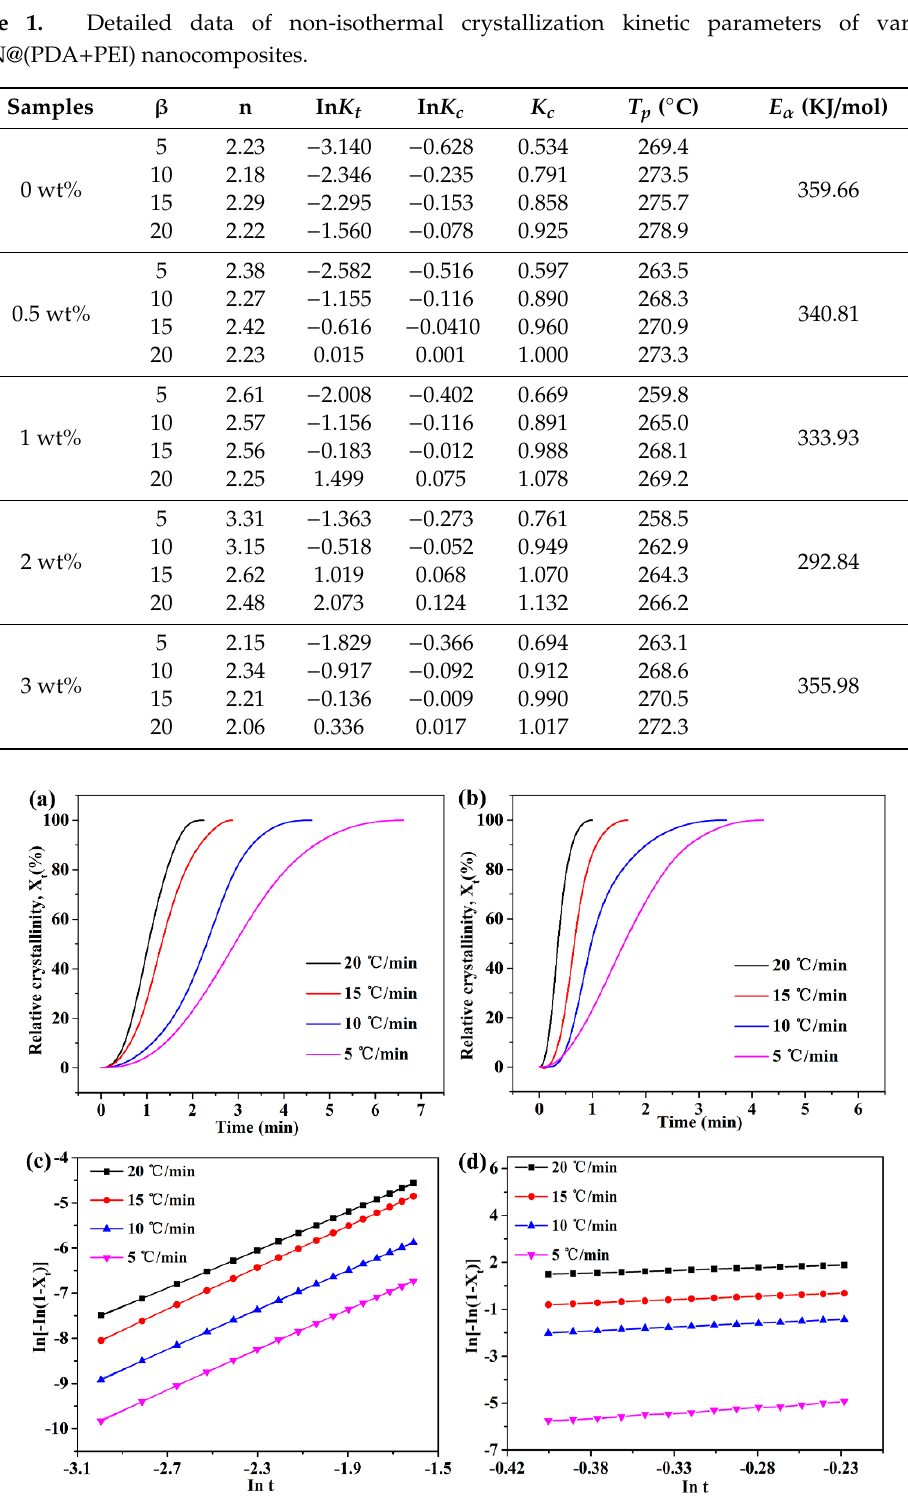
Figure 6. The relative crystallinity and Avrami of neat PEN ( a , c ) and PEN nanocomposite film with 2 wt% h-BN@(PDA + PEI) ( b , d ), respectively. Table 1. Detailed data of non-isothermal crystallization kinetic parameters of various h-